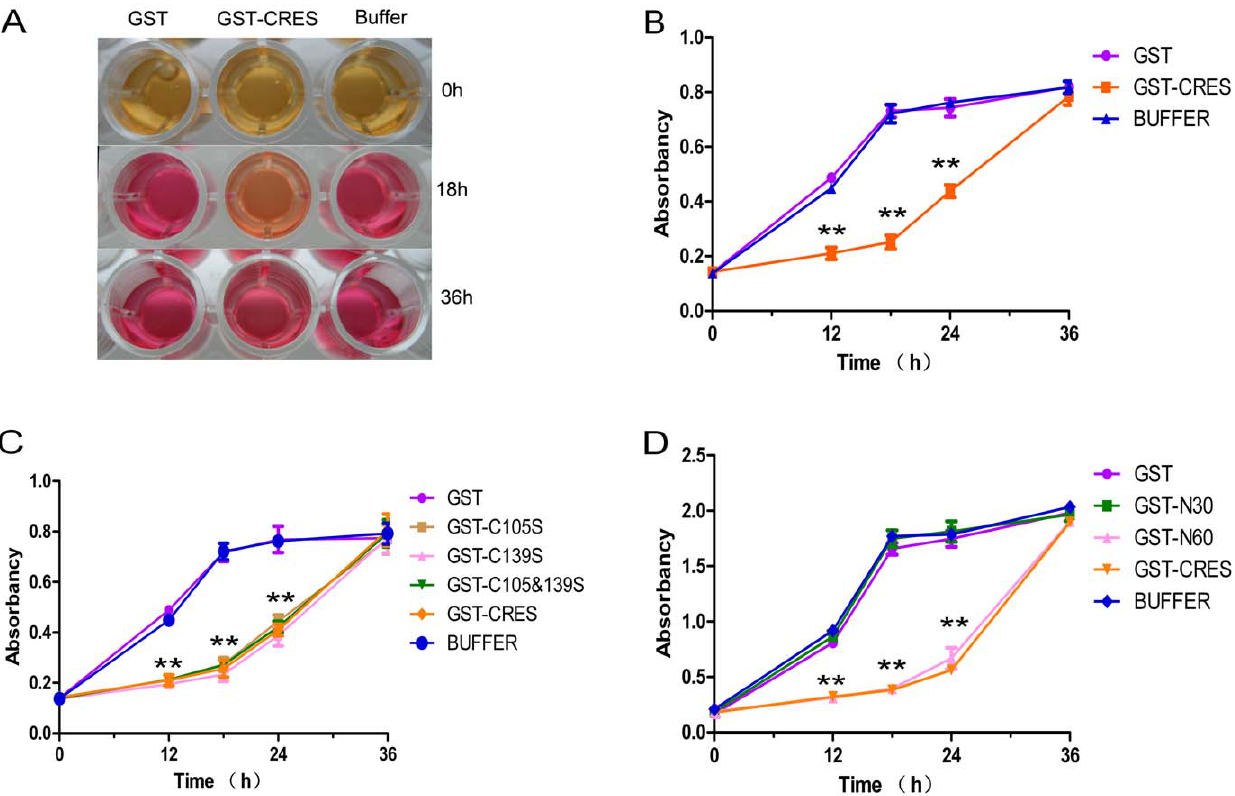
incubated with 100 ng/ml GST (purple), C105 mutant (brown), C139 mutant (pink), C105 & C139 mutant (green), GST-CRES (orange) and buffer (blue) for 0 h, 12 h, 18 h, 24 h and 36 h. (D) Uu incubated with 100 ng/mL GST (purple), GST-N30 (green), GST-N60 (pink), GST-CRES (orange) and buffer (blue) for 0 h, 12 h, 18 h, 24 h and 36 h. ** p , 0.01.